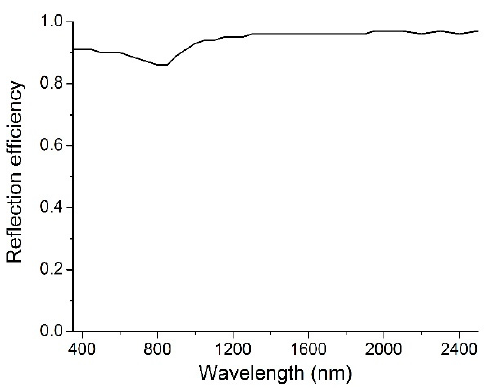
Figure 10. Spectral reflectance of the aluminum-coated film. Table 2. Analyses of the module efficiency for a module with specific fabrication factors.